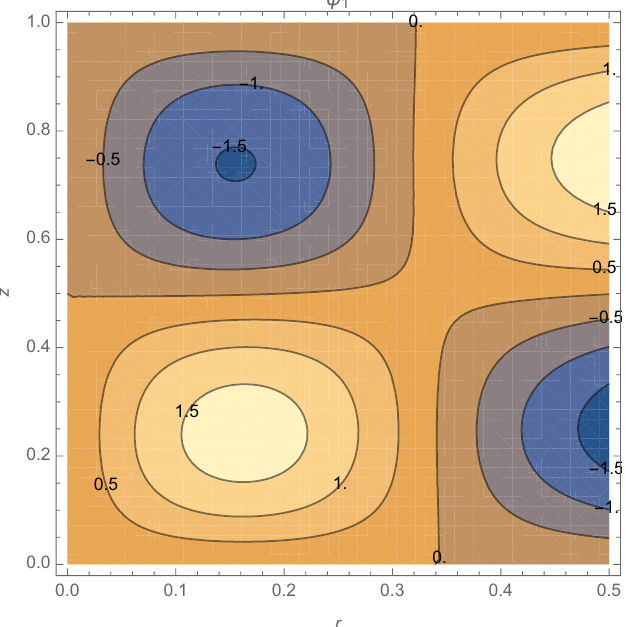
(cid:113) + 4 π 2 , case of the magnet. See text for details. x 2 Figure 3. The first-order flow function ψ 1 for λ = 02 Interestingly, the contour lines, created by the boundary condition on the magnet, tend to remain concentrated in the left part of the figure with increasing α . The perturbed field shows localized closed convex field lines typical of the plasma. So, the boundary condition on the magnetic field support the plasma structure of the spheromak or the protosphera. The model has too many contraints: the magnet condition B z ( r , 1 ) = J 0 ( γ r ) θ ( 1/2 − r ) is a constraint also for the gun inflow and there is no free choice for λ values because the condition on B z ( r , 1 ) imposes γ 2 = λ 2 − 4 π 2 = x 2 , so that, with this model, one cannot 02 study the resonances due to the zero of the denominators in ψ 1 ; see Equation (44). It